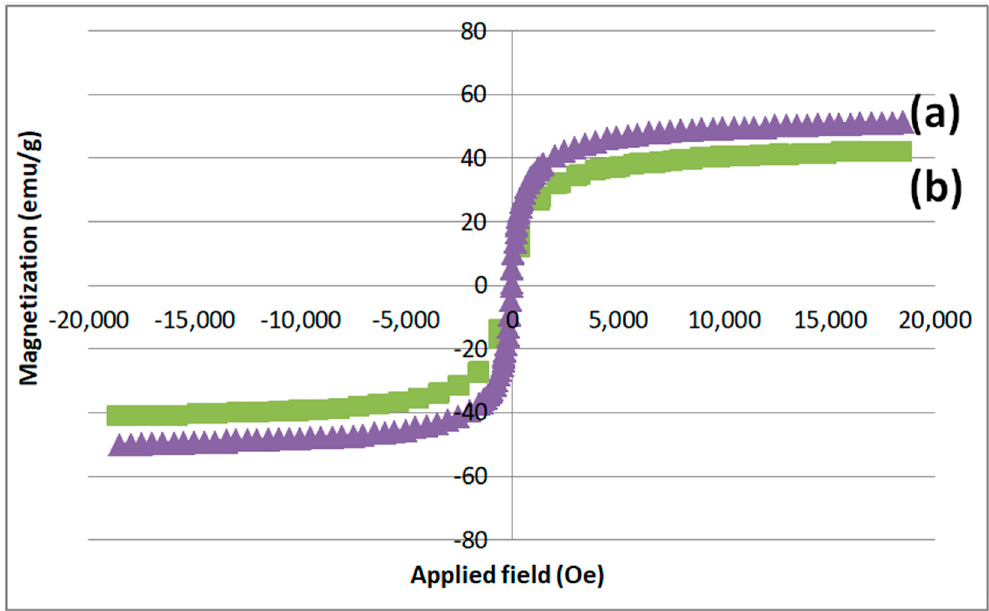
Figure 5. VSM plots of the synthesized: ( a ) PEG-MNPs; and ( b ) Co 2+ -doped PEG-MNPs.